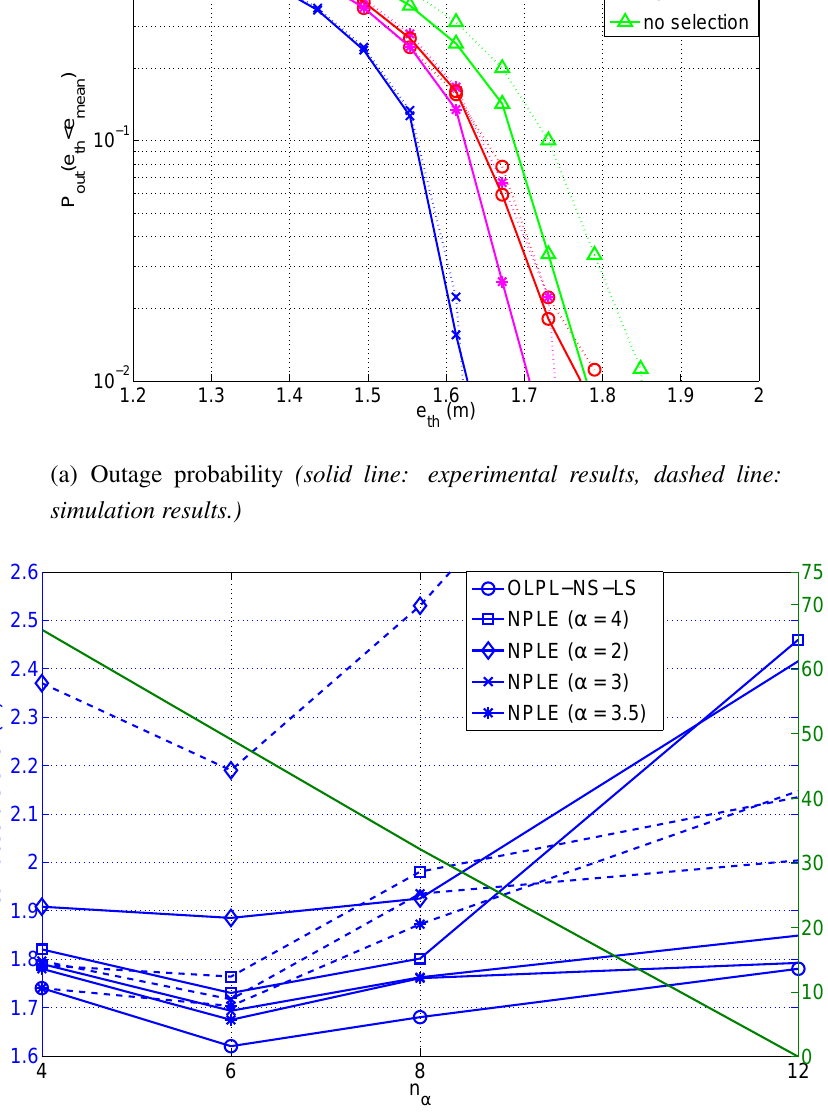
Figure 11. Results at Scenario 1.